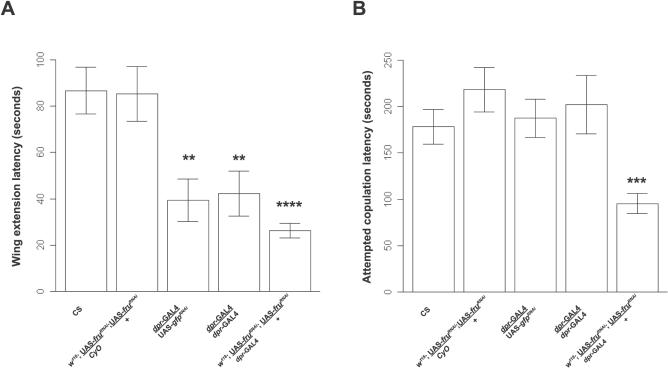

dpr Mutant Males Show Reduced Courtship Latency(A) Time (s) to first wing extension for CS male flies (n = 30, mean = 86.7, SE = 9.9) is significantly different (one-tailed t-test) than dpr-GAL4 (n = 26, mean = 42.3, SE = 9.6) (p < 2.95E-5), dpr-GAL4;UAS-gfp
RNAi (n = 50, mean = 39.4, SE = 9.3) (p < 1.73E-8), and dpr-GAL4;UAS-fru
RNAi (n = 66, mean = 26.2, SE = 3.1) (p < 3.00E-10) flies. Also, when compared to UAS-fru
RNAi (n = 38, mean = 85.3, SE = 11.7) male control flies, the time to first wing extension is significantly reduced in dpr-GAL4 (p < 2.21E-4), dpr-GAL4;UAS-gfp
RNAi (p < 2.28E-7), and dpr-GAL4;UAS-fru
RNAi (p < 2.71E-9) flies.(B) The time to first attempted copulation (s) is significantly reduced in dpr-GAL4;UAS-fru
RNAi (n = 63, mean = 95.3, SE = 10.8) flies compared to CS (n = 27, mean = 178.3, SE = 18.3) (p < 3.20E-5), UAS-fru
RNAi (n = 33, mean = 218.5, SE=23.6) (p < 1.03E-6), dpr-GAL4;UAS-gfp
RNAi (n = 45, mean = 187.5, SE = 20.9) (p < 3.41E-5), and dpr-GAL4 (n = 24, mean = 202.2, SE = 31.1) (p < 1.45E-4) male flies. Error bars represent SE. Mann-Whitney rank-sum test: **, p < 1.0E-3; ***, p < 1.0E-4; ****, p < 1.0E-8.doi:0.1371/journal.pgen.0030216.g007